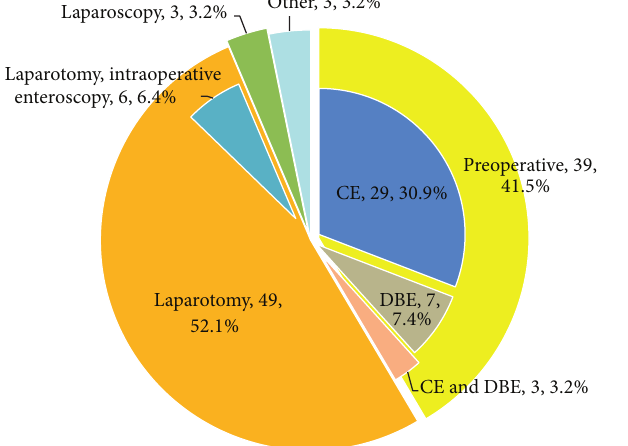
Figure 3: Diagnostic methods. Other methods included autopsy (one case), small bowel enema (one case), and sigmoidoscopy (one case).